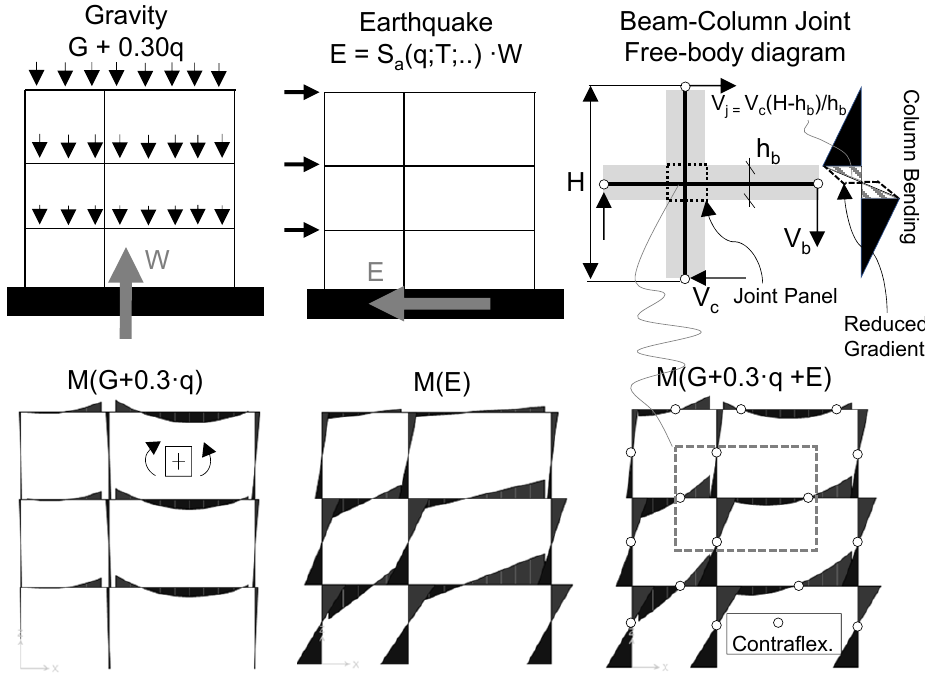
Figure 1. Beam–column joint definition for a planar moment-resisting frame under gravity and lateral forces. (Notes. The diagram of bending moment (M) are obtained from a simplified 2D analysis carried out on SPEAR